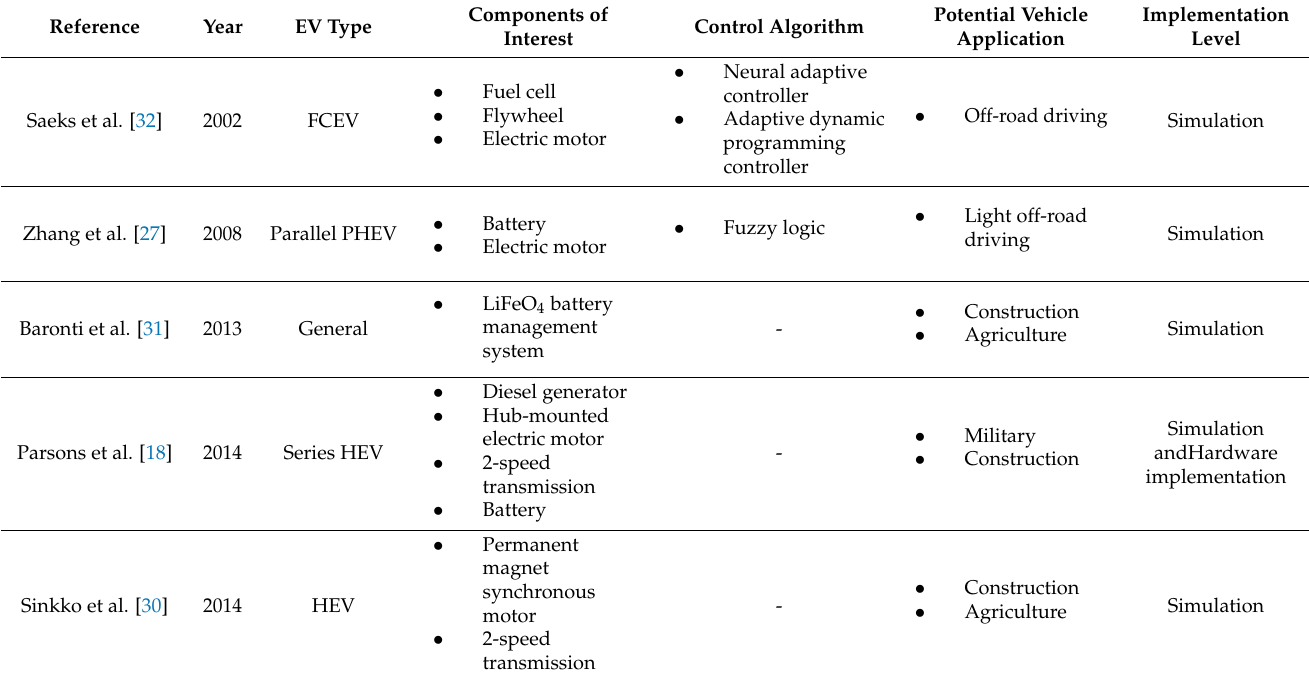
Table 2. Academic literature overview of general off-road EV